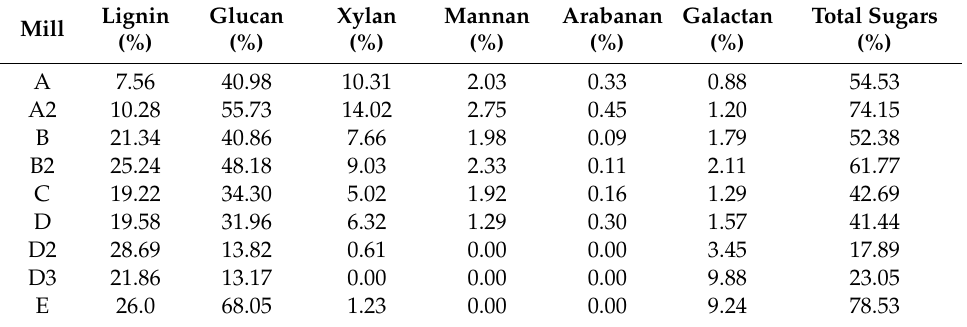
Table 2. Characterization of chemical constituents (dry weight basis) in the various sludge samples. All expressed as a percentage of total biomass dry weight. The same sludge materials used in study conducted by Gurram et al. [15].